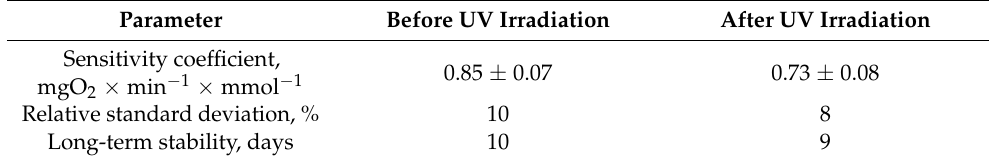
Table 3. The characteristics of the biosensor based on immobilized yeast cells in an organosilica STP EG -composite after UV irradiation.